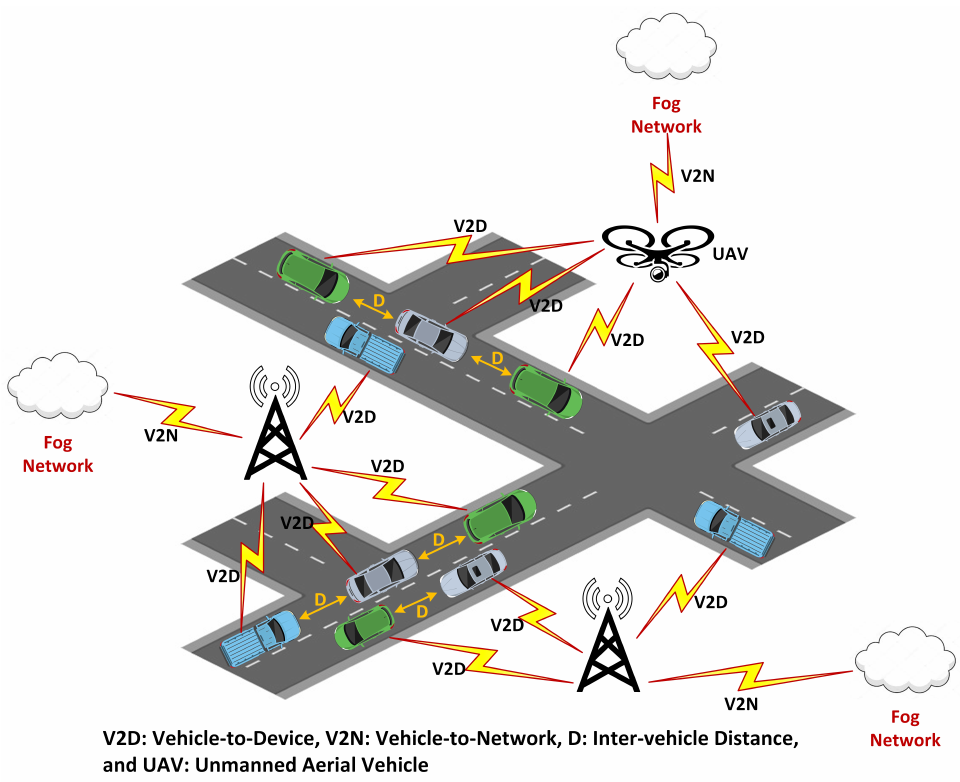
Figure 4. The platooning of self-driven vehicles maintaining a fixed distance ‘D’ between them.